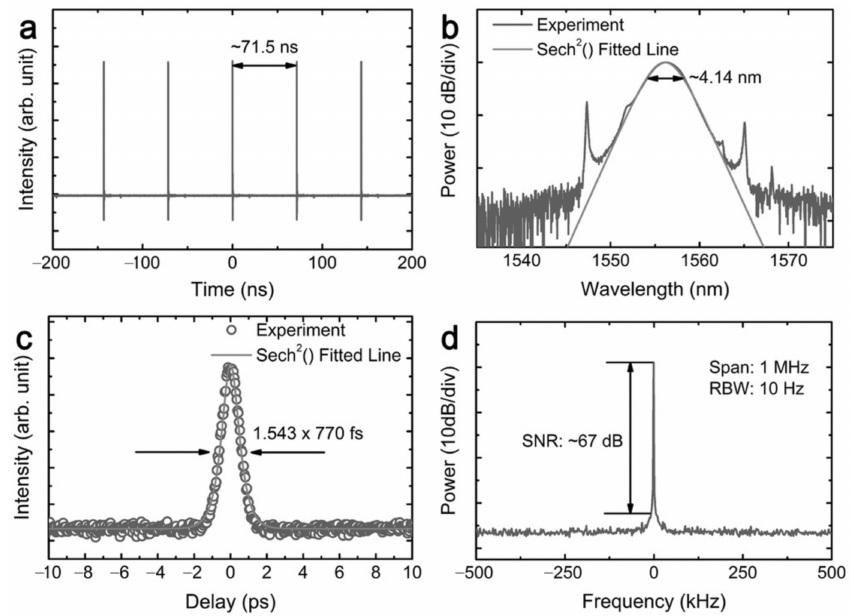
Figure 10. Measured ( a ) oscilloscope trace, ( b ) optical spectrum, ( c ) autocorrelation trace and ( d ) electrical spectrum of the output optical pulses (SNR: signal-to-noise ratio, RBW: resolution bandwidth). Reprinted with permission from